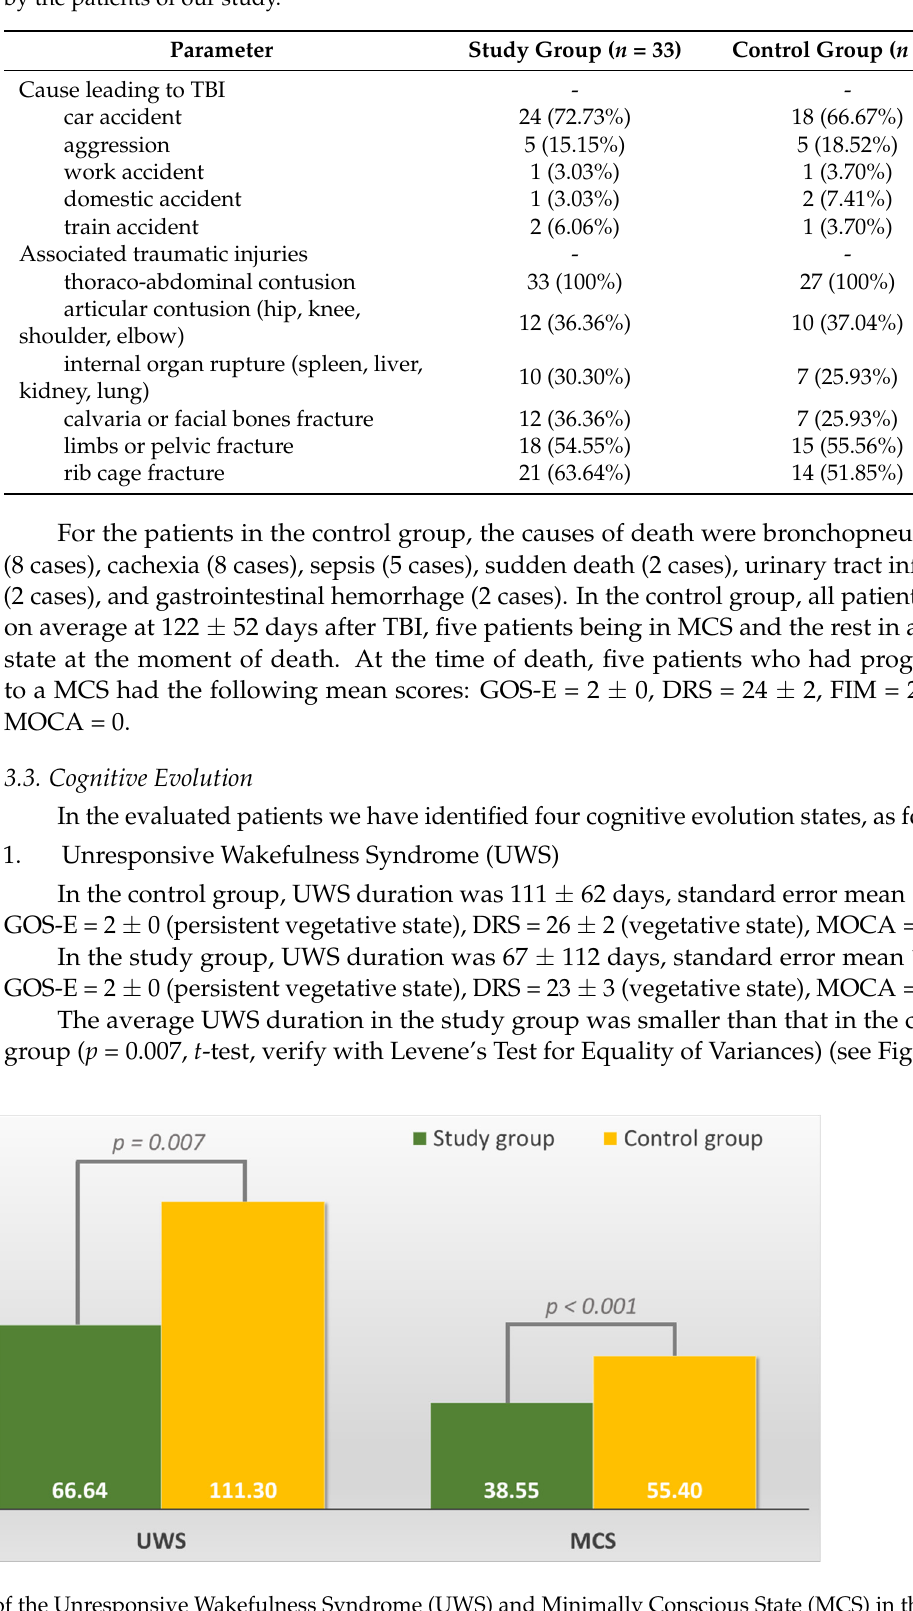
Table 2. Overview of the leading cause of the TBI and other associated traumatic injuries sustained by the patients of our study.